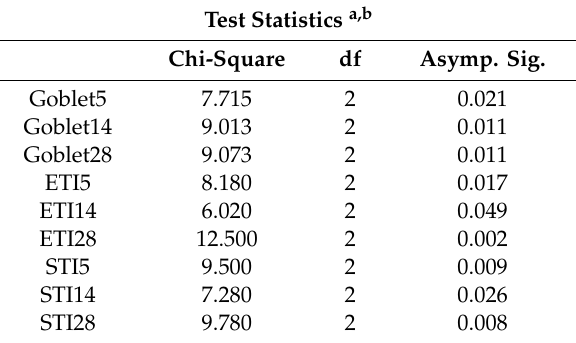
Figure 10. Epithelial thickness index (ETI) value distribution (boxplot representation).